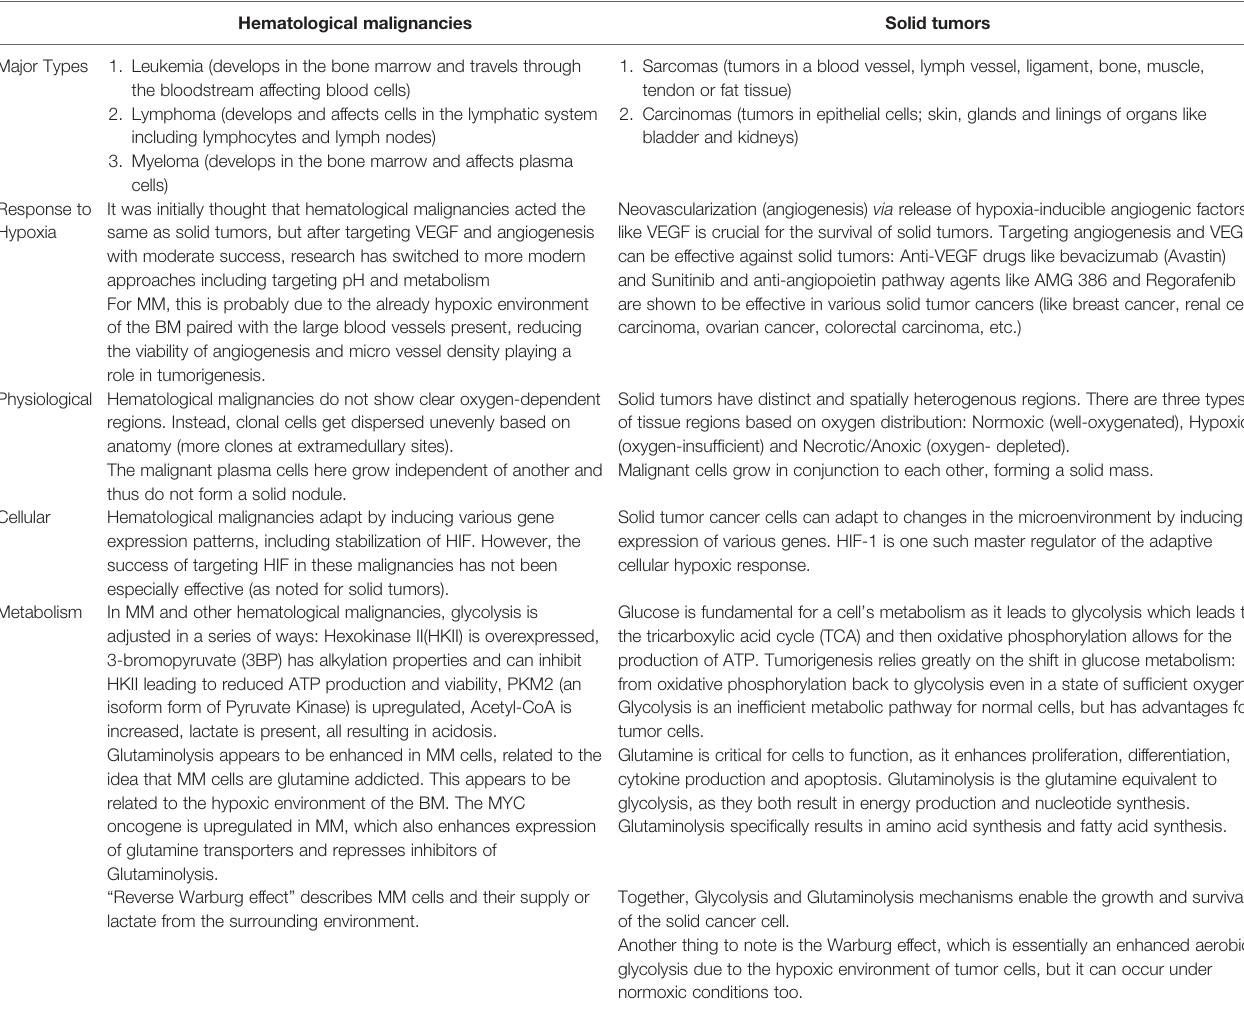
TABLE 1 | Summary table comparing oxygen-related similarities and differences between hematological and solid tumors. Hematological malignancies Solid